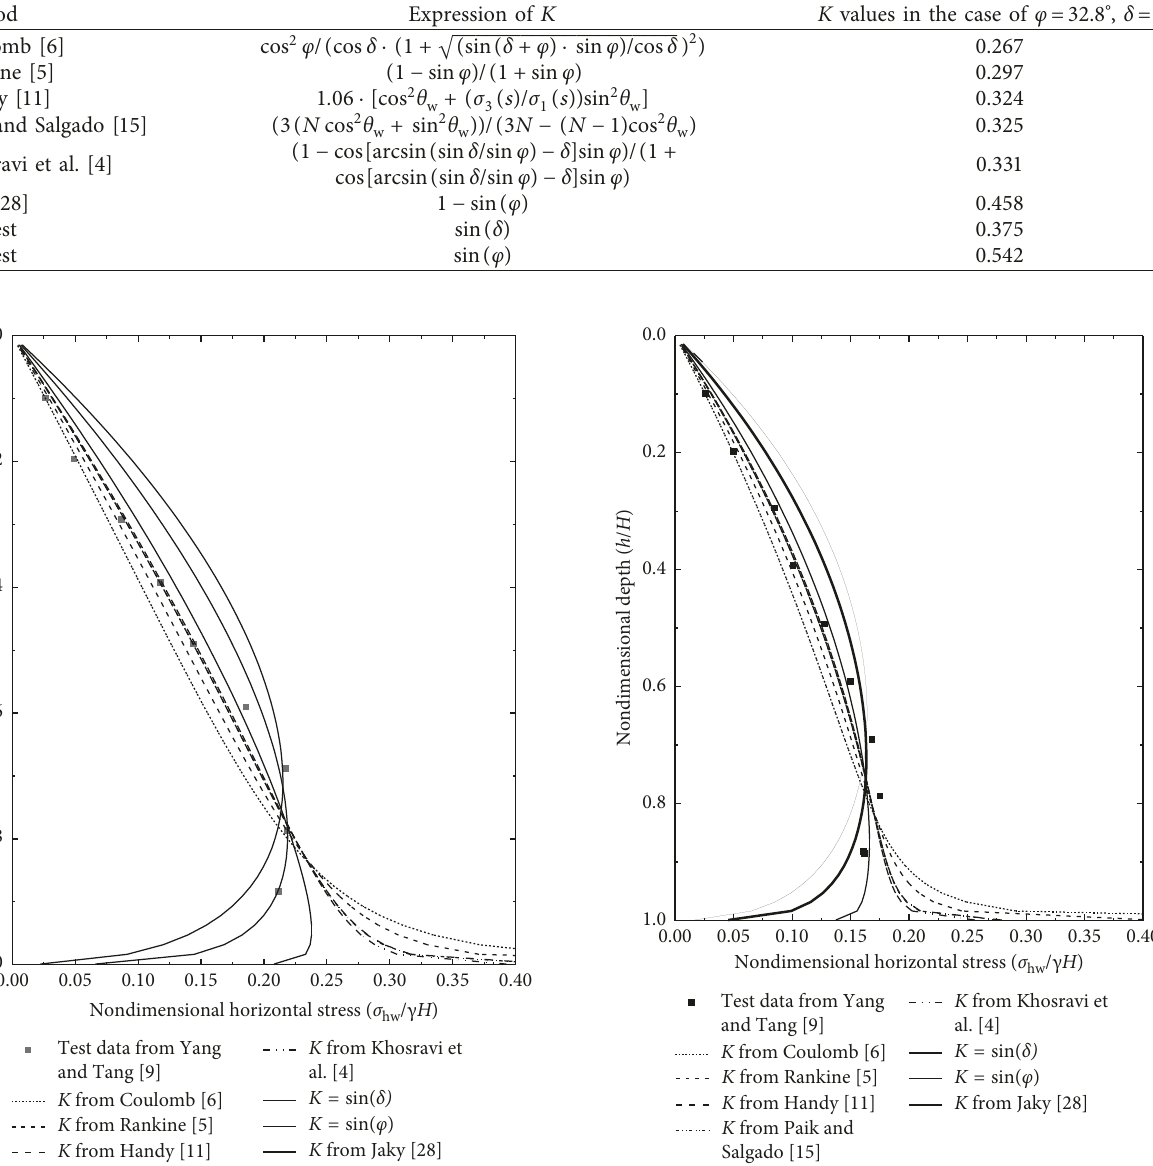
Figure 6: Measured and calculated dimensionless earth pressure versus h / H , for width �